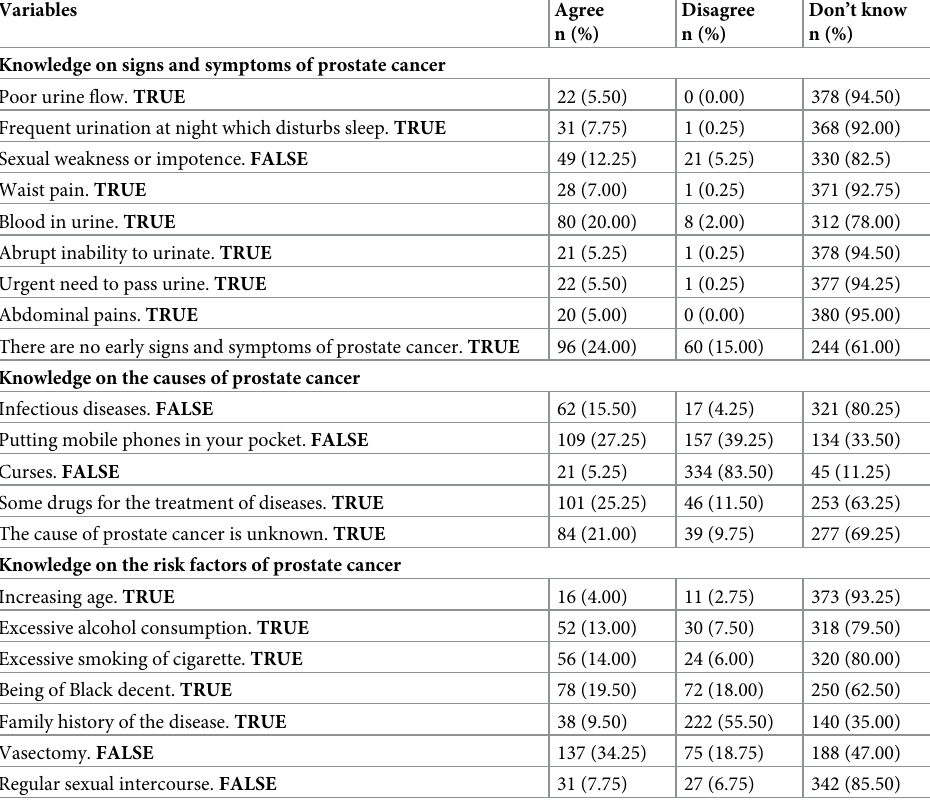
(83.50%), and the majority of them did not belong to any market associations. Table 2 indicates the responses of the study subjects on their knowledge of the signs and symptoms, causes, and risk factors of PCa. Amongst the nine (9) items that assessed the partic- ipant’s knowledge about the signs and symptoms of PCa, none of these knowledge items received a correct response from at least 25.00% of the respondents. Between 61.00–95.00% of the respondents did not know the response to give regarding these knowledge items. In the assessment of knowledge about the causes of PCa, five (5) knowledge questions were adminis- tered. Amongst these, 83.50% of the respondents correctly indicated that curses could not cause prostate cancer. Approximately, one-fourth of the participants correctly responded that some pharmaceutical agents could cause PCa, whilst 27.25% of the study subjects wrongly implicated mobile phones as a cause of PCa. When the participants were asked about the possi- bility of infectious diseases causing PCa, 80.25% could not choose between ‘‘agree” or ‘‘dis- agree”. About 70% of the participants could not also tell if PCa had potential causes. The third domain of knowledge assessment was examined with seven (7) items of which none had a 20.00% correct response from the participants. As low as 4.00% and approximately 10.00% of Table 2. Knowledge about prostate cancer (n =